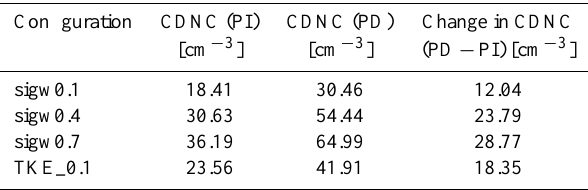
Table 6. Global mean cloud droplet number concentration at 720m for each model configuration.